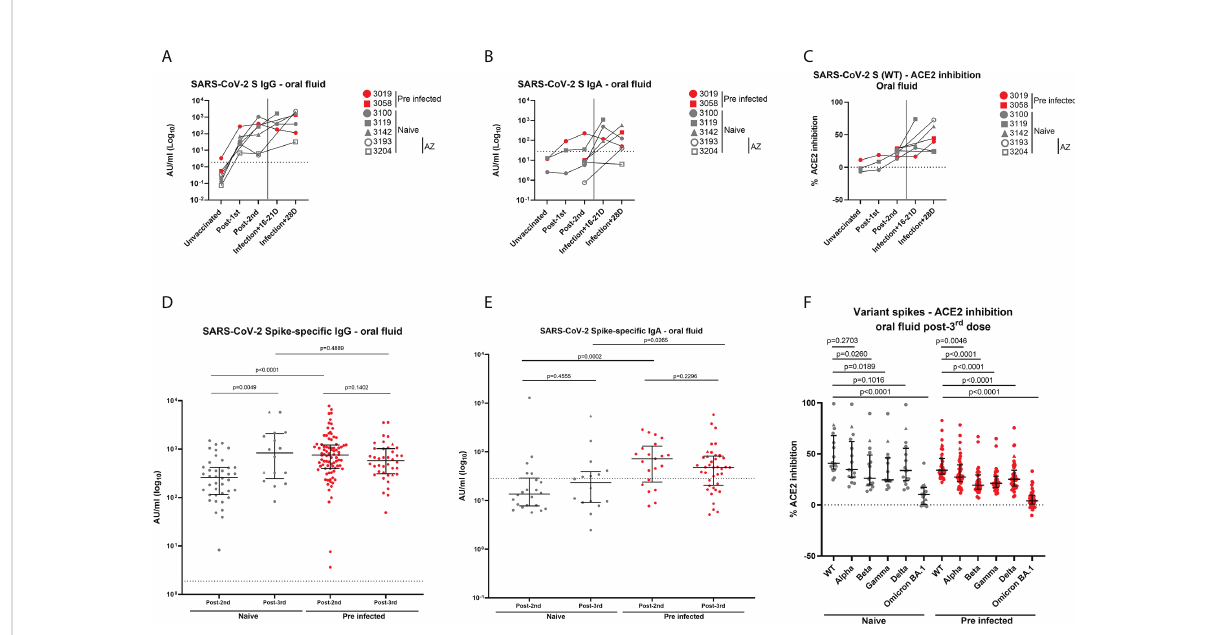
FIGURE 7 Antibody levels in oral fl uid and ability of oral fl uid to inhibit ACE2 binding to SARS-CoV-2 spike after a breakthrough infection or a 3 rd dose of mRNA vaccine. (A) IgG concentrations (AU/ml) and (B) IgA concentrations (AU/ml) determined in oral fl uid samples from fi ve naïve and 2 previously-infected individuals 16-28 days after breakthrough infections using MSD ® immunoassay. (C) Inhibition of ACE2 binding to Wuhan SARS-CoV-2 spike (WT) by oral fl uid samples from above-mentioned naïve and previously-infected individuals 16-28 days after breakthrough infections determined using MSD ® ACE2 inhibition assay. (D) IgG concentrations (AU/ml) and (E) IgA concentrations (AU/ml) determined in oral fl uid from naïve and previously-infected HCWs 28 days post-2 nd dose and 28 days post-3 rd dose using MSD ® immunoassay. (F) Comparison of ACE2 binding inhibition to SARS-CoV-2 variant spike antigens (WT, Alpha, Beta, Gamma, Delta, Omicron BA.1) post-3 rd dose. Wilcoxon and Mann-Whitney tests were used to determine the statistical signi fi cance between the groups of paired and unpaired samples, respectively. (D – F) Triangles show the individuals who experienced a breakthrough infection between the 2 nd and 3 rd